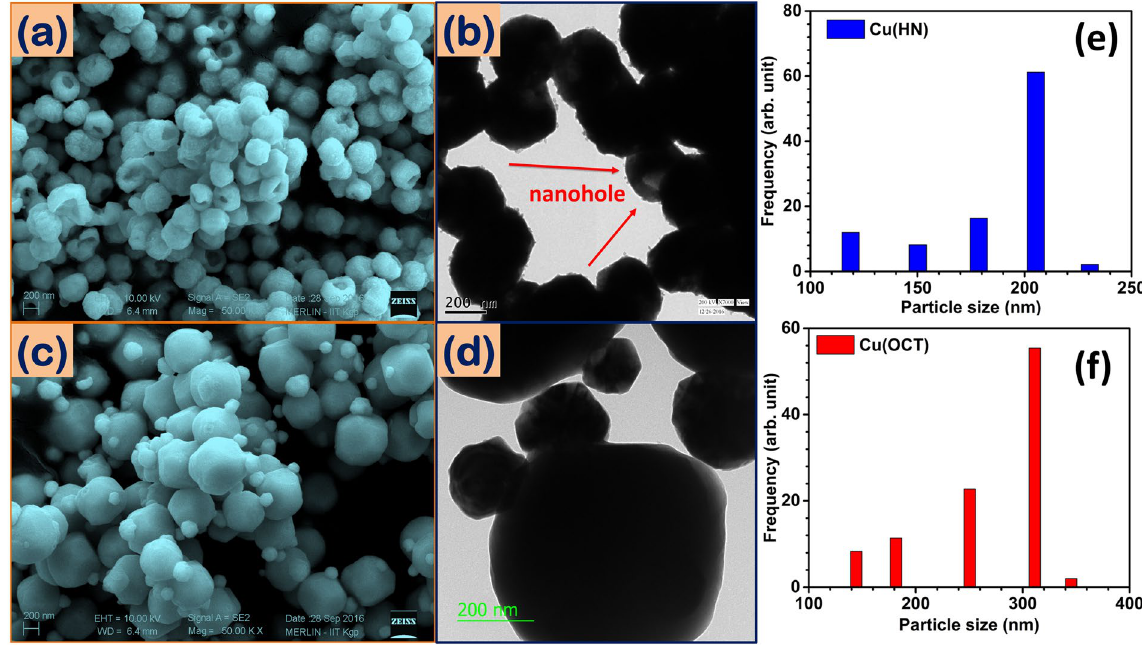
Figure 1. ( a , c ) SEM, ( b , d ) TEM images and ( e , f ) particle size distribution of Cu(HN) and Cu(OCT),